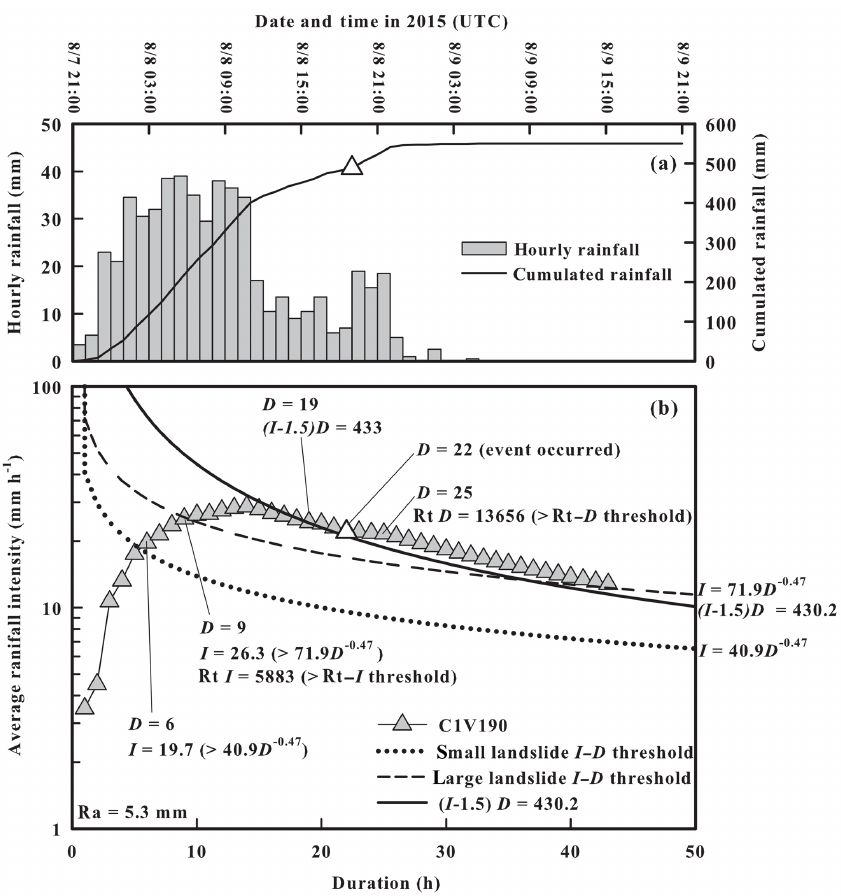
Figure 8. (a) Hourly and cumulated rainfall record for rainfall station C1V190. The white triangle shows the time of the large landslide occurring in 2015. (b) The rainfall threshold of the critical height of water model issued the early warning 3h before the landslide initiated (white